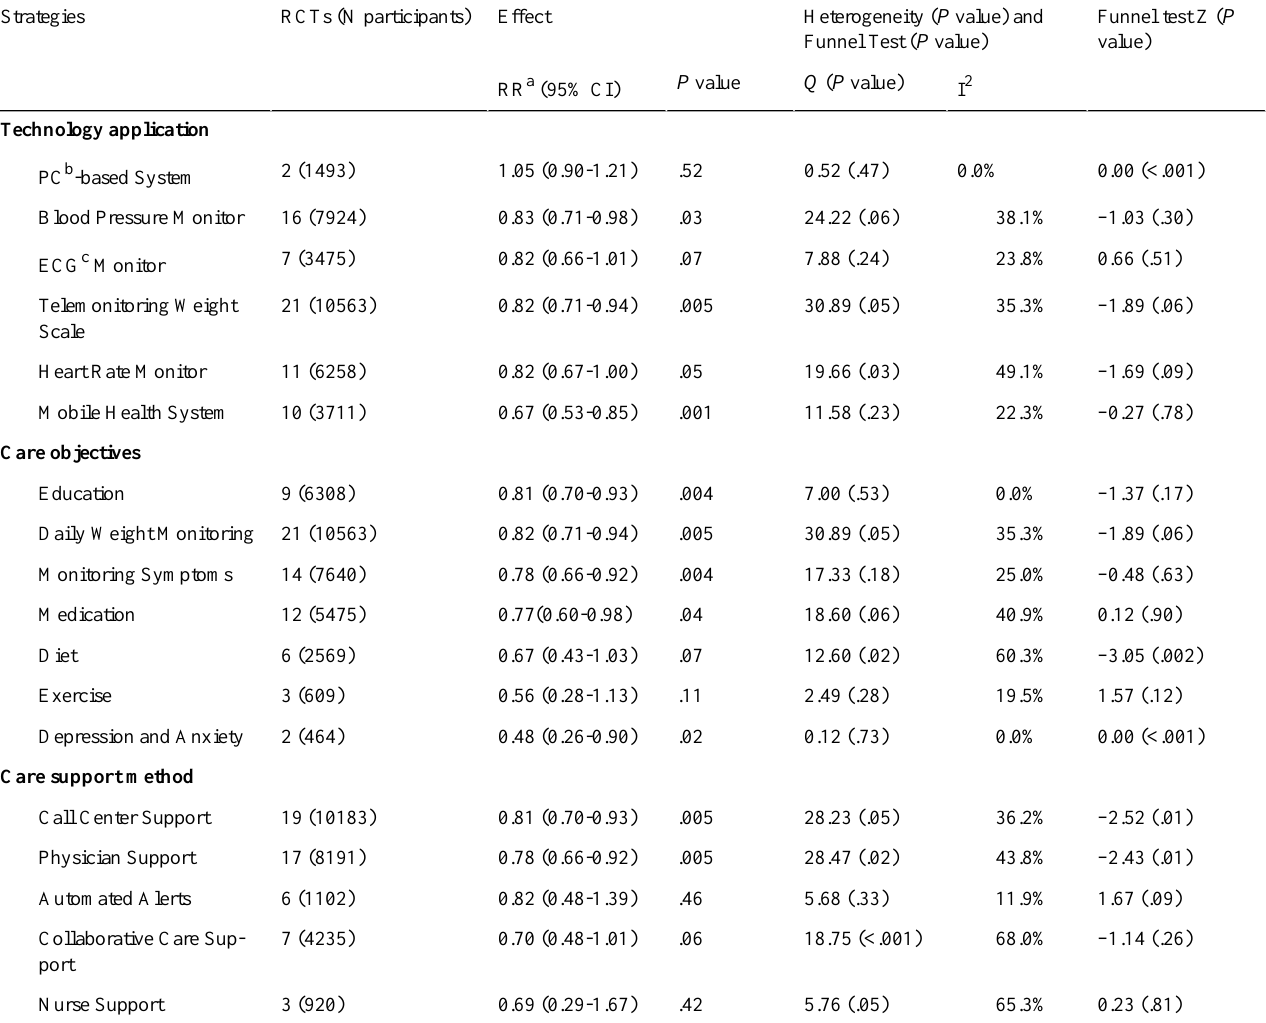
Table 7. Subgroup meta-analysis to examine the effect of telemonitoring strategies on mortality in randomized controlled trials (RCTs) that applied the strategy in the telemonitoring intervention (subgroup